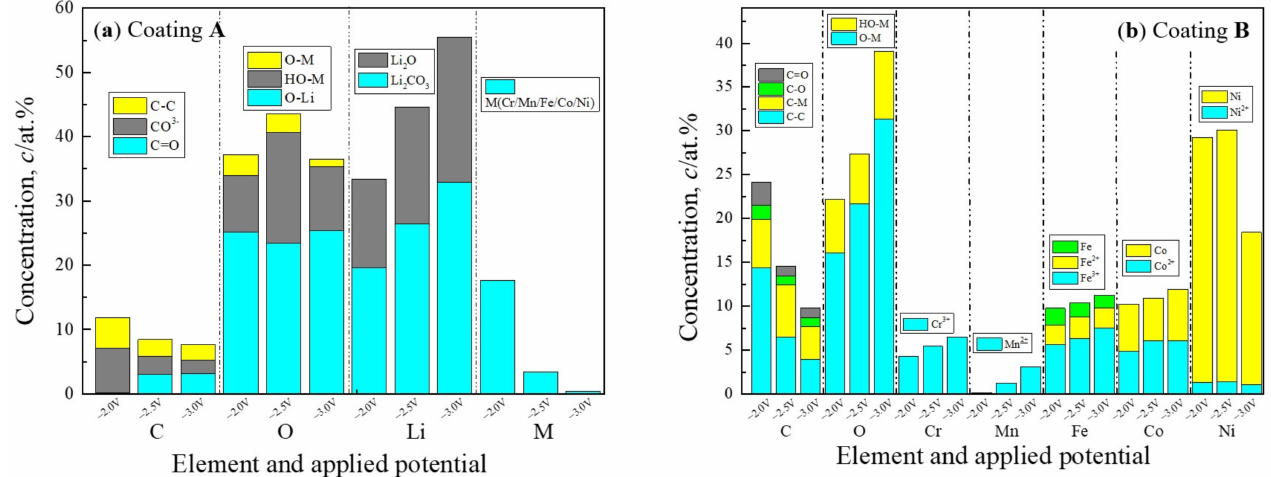
Figure 10. Quantitative concentration of elements obtained in coating A ( a ) and coating B ( b ) from Figures 8 and 9 (XPS analysis).